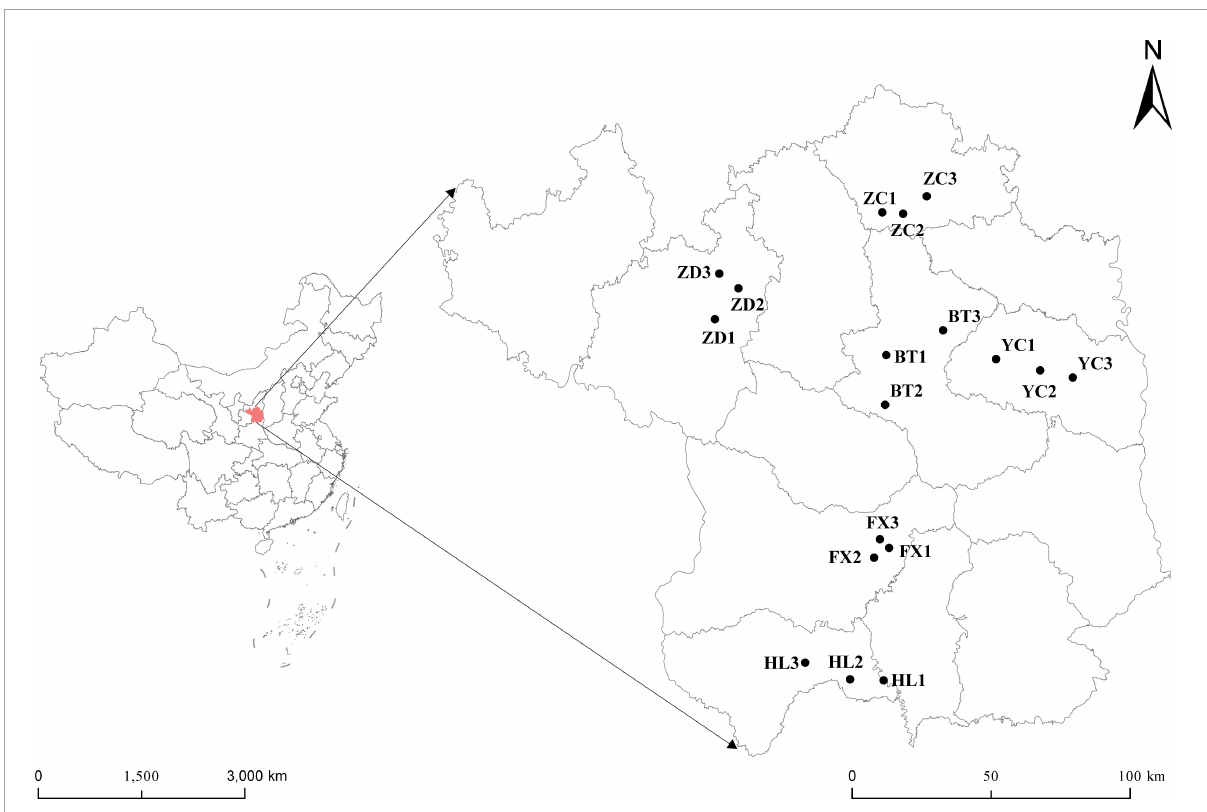
FIGURE1 Geographical distribution of the six sampling sites of S . davidii in China. The simplified map shows six sampling areas of Huangling (HL), Fuxian (FX), Baota (BT), Yanchang (YC), Zhidan (ZD), and Zichang (ZC) in Yan’an city, Shaanxi Province. Each sampling area includes three sampling